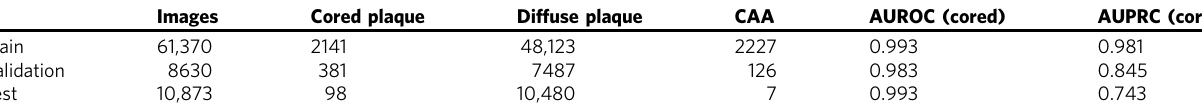
Table 2 Annotated object dataset distribution by class and model performance Images